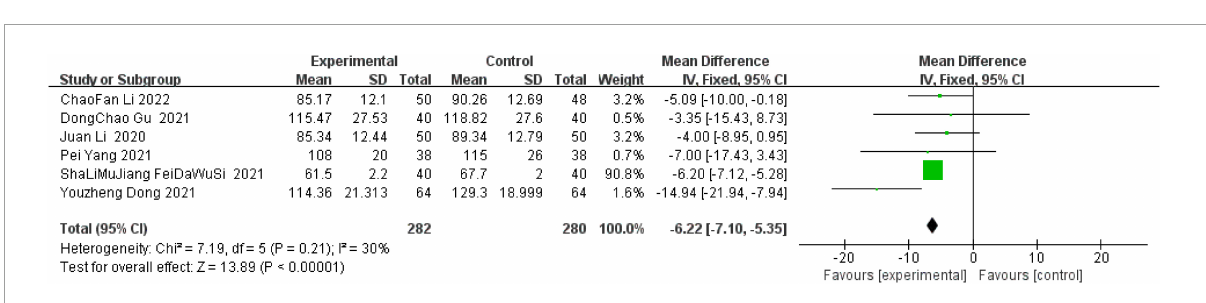
FIGURE7 Left ventricular end-diastolic volume (LVEDV) within 6 months after